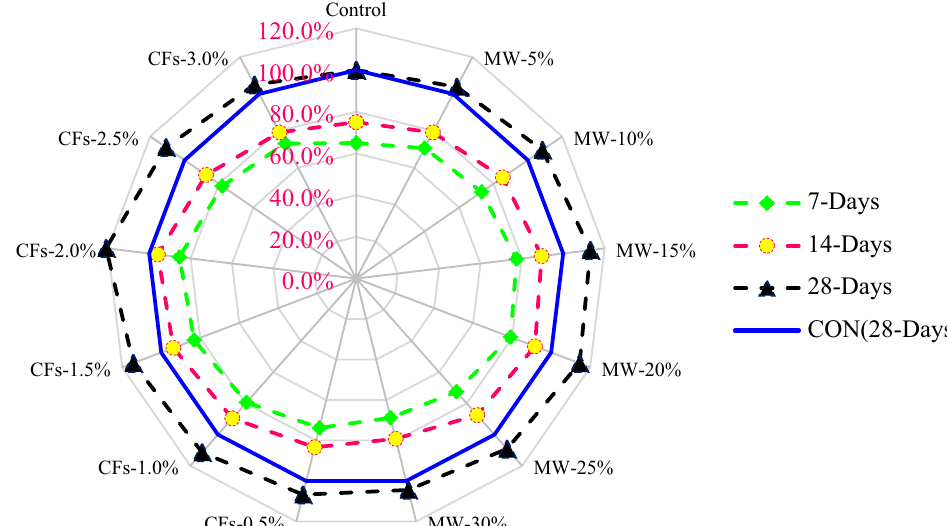
Figure 19. Relative analysis of flexure strength.